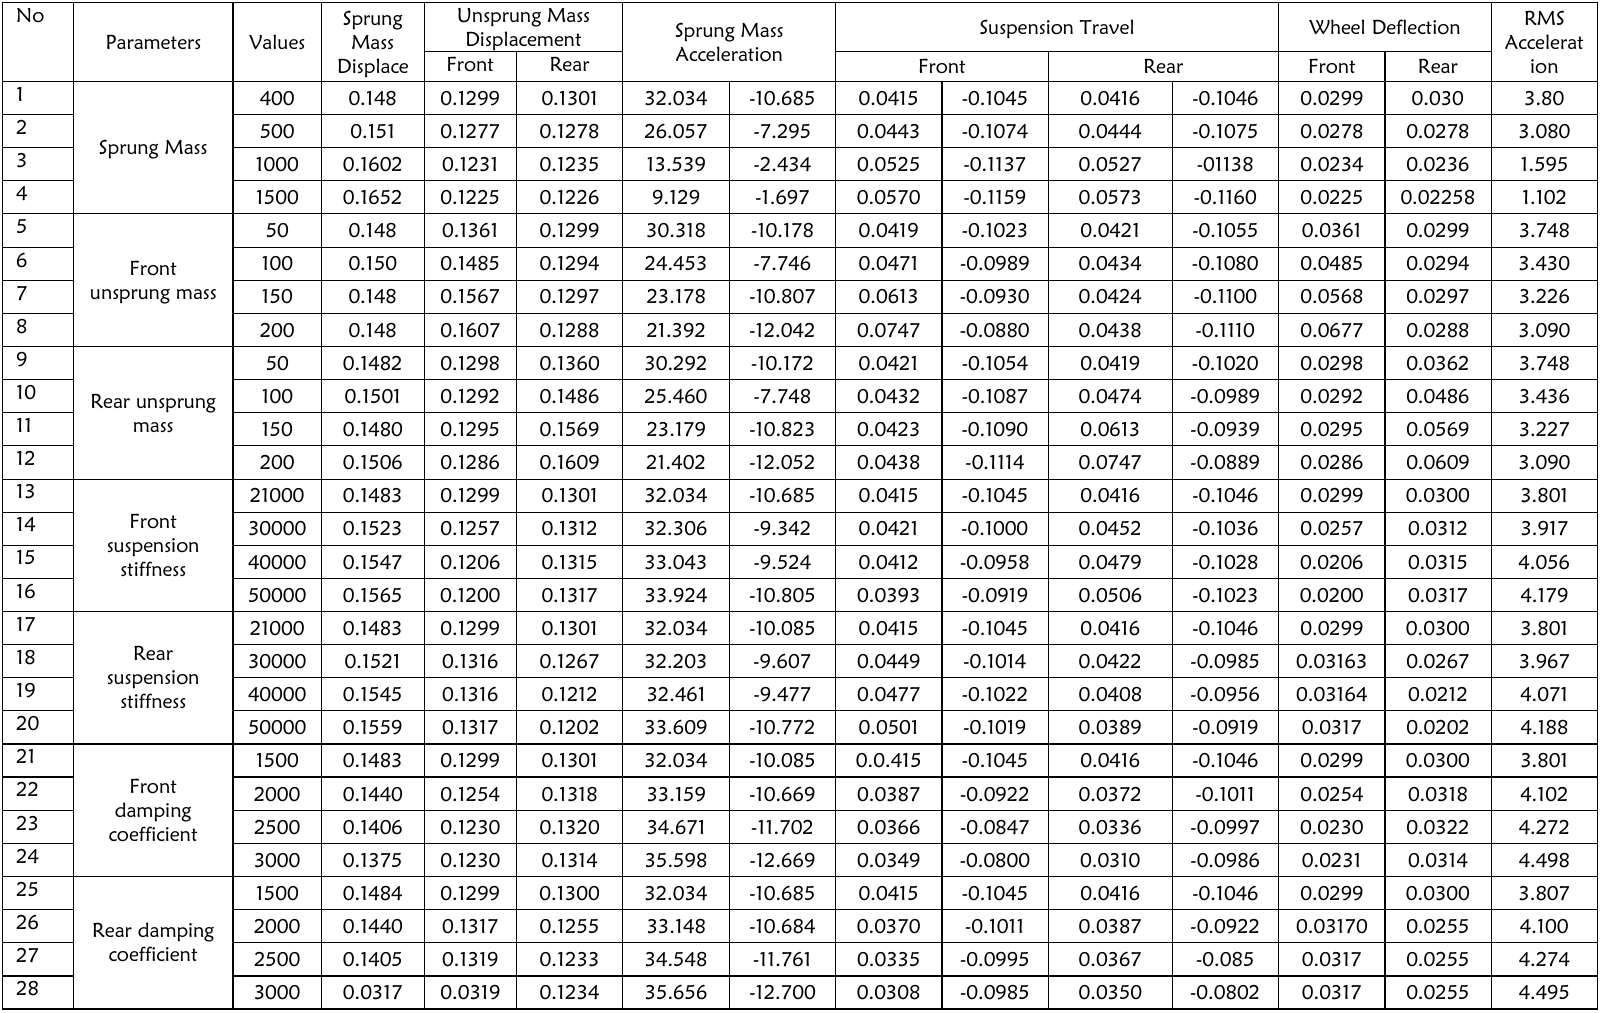
Table 4. Simulation results for half car